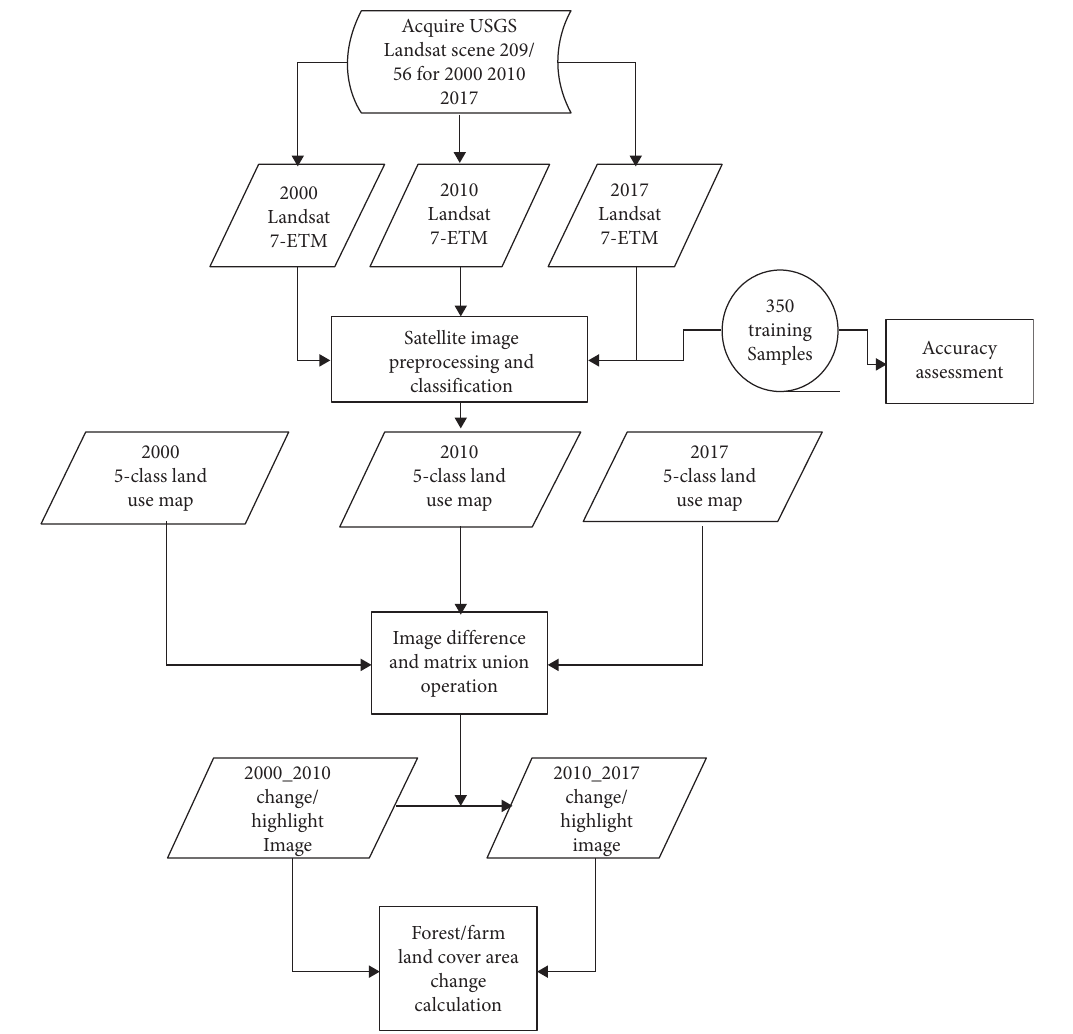
Figure 5: Workflow for farmland change